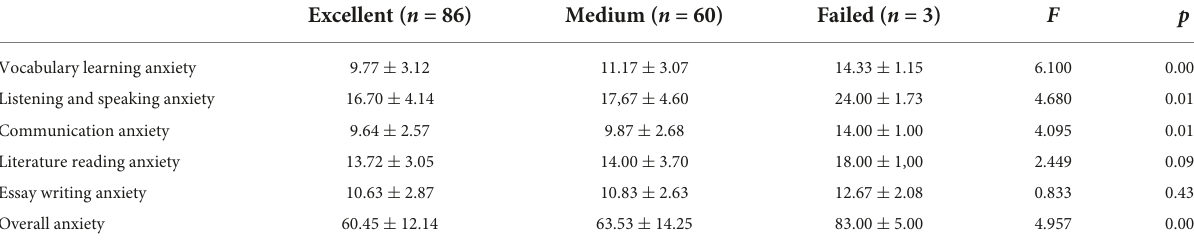
TABLE 8 Score difference in language achievement.